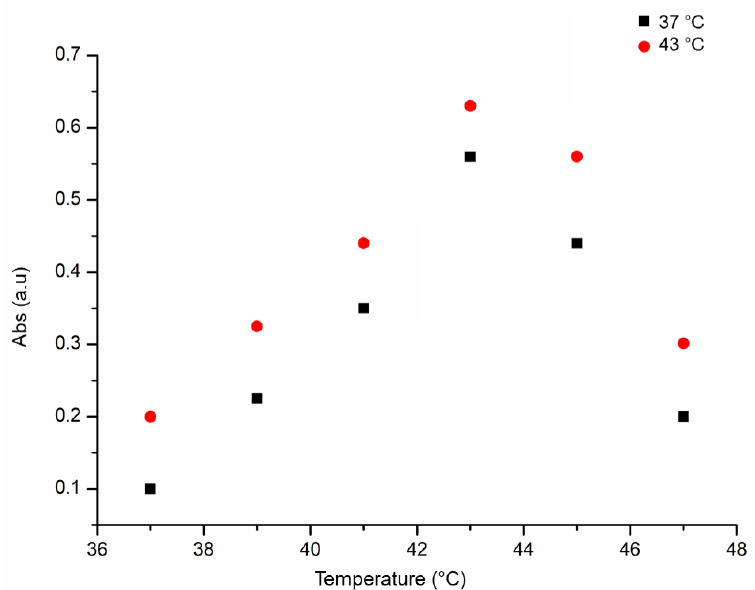
Figure 3. Thermo sensibility of SiO 2 @LA NPs (10 and 40 µg/mL) measured at different temperatures (37 °C, 39 °C, 41 °C, 43 °C, 45 °C, 47 °C).